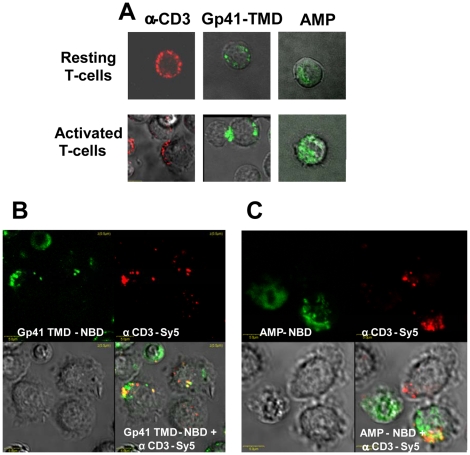
Gp41 TMD co-localizes with CD3 within the TCR complex.Gp41 TMD-NBD and AMP-NBD were used to study peptide binding to the membranes of resting and activated T cells in combination with Sy5-labeled antibodies to CD3. The T cells had been activated by incubation with APC and the MOG 35–55 peptide. (A) Distribution of gp41 TMD-NBD, AMP-NBD and CD3 molecules in resting and activated T cells. (B) Co-localization of gp41 TMD-NBD with the CD3 molecules. (C) Co-localization of AMP-NBD with the CD3 molecules.